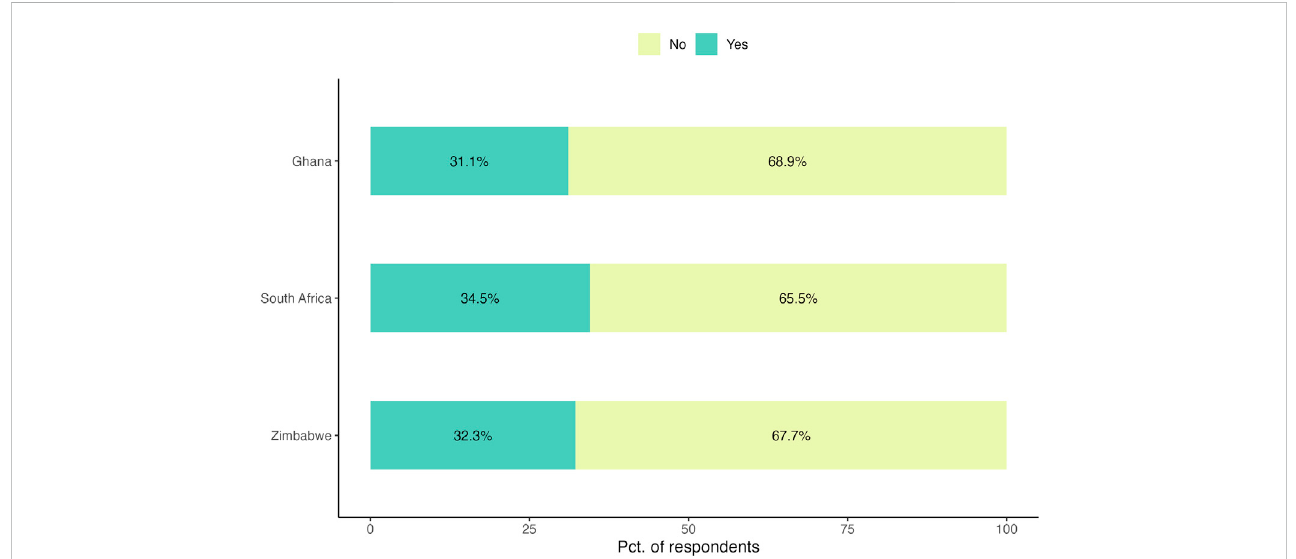
FIGURE 5 Thesurveyinvitedrespondentstochoosebetween “ Yes ” and “ No ” inregardtothestatementC2 “ Soilisalivingthing ” .Thisshowsthatapproximatelyone- third ofrespondentsin Ghana(31.1%),SouthAfrica(34.5%) and Zimbabwe (32.3%) consider soilto bealivingthing. These results speakto aneed for increased educational efforts with respect to the living nature of